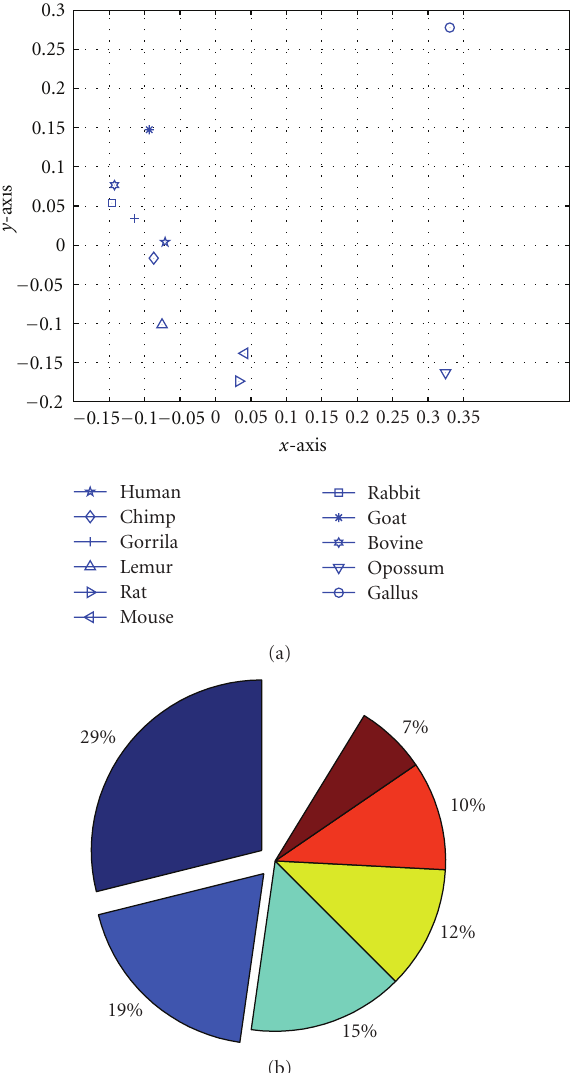
Figure 2: (a) The projection of the 336-dimensional vectors of 11 species on a 2D space composed of the top two principal compo- nents; (b) The contributions of the first 6 principal